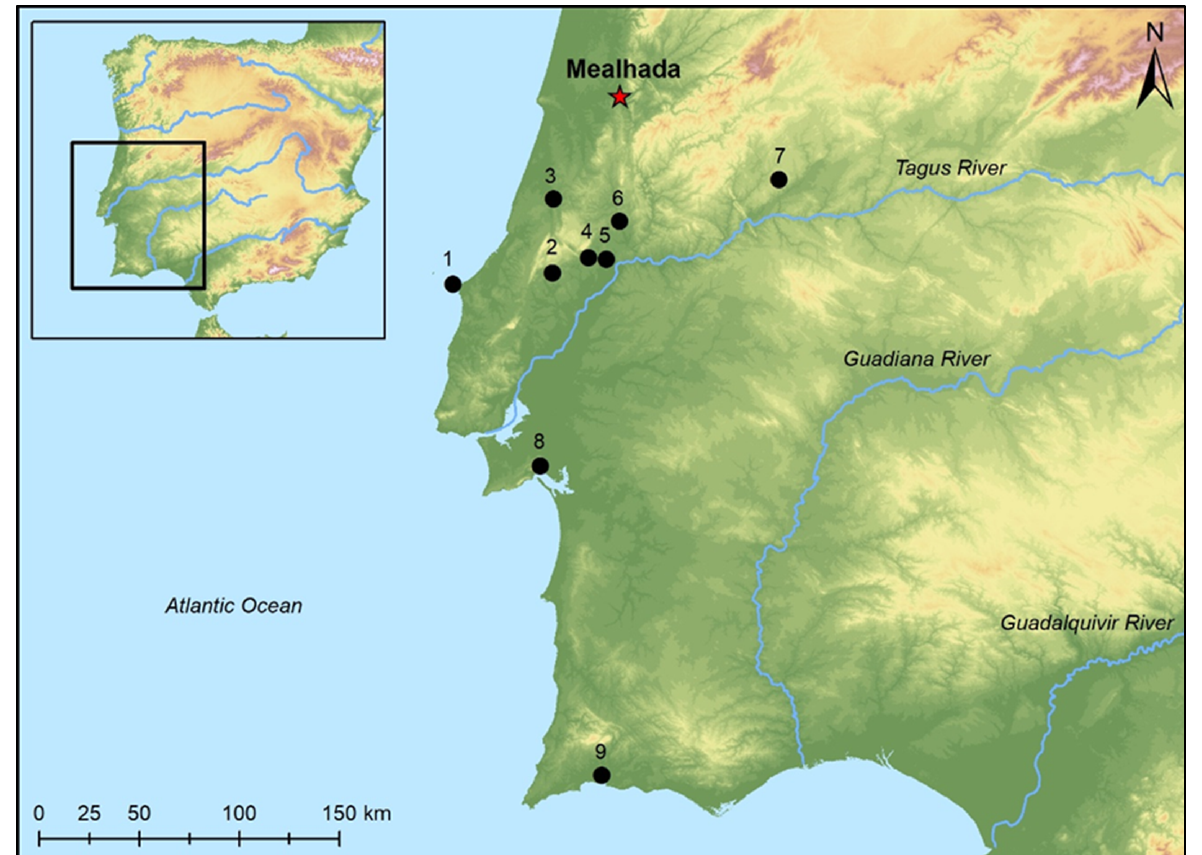
Figure 1. Mealhada Middle Palaeolithic site location on the Iberian Atlantic Coast (Coimbra, central Portugal). Other Portuguese Palaeolithic archaeological turtle records mentioned in the text are: (1) Gruta da Furninha (Peniche); (2) Lapa do Picareiro (Alcanede); (3) Gruta Nova da Columbeira (Bom ‐ barral); (4) Galeria Pesada (Almonda); (5) Gruta da Oliveira/Gruta da Aroeira (Torres Novas); (6) Gruta do Caldeirão I/ Gruta do Morgado Superior (Tomar); (7) Foz do Enxarrique (Vila Velha de Ródão); (8) Gruta da Figueira Brava (Arrábida); (9) Gruta Ibn Amar (Lagoa) (Map: Pablo Paniego Díaz).